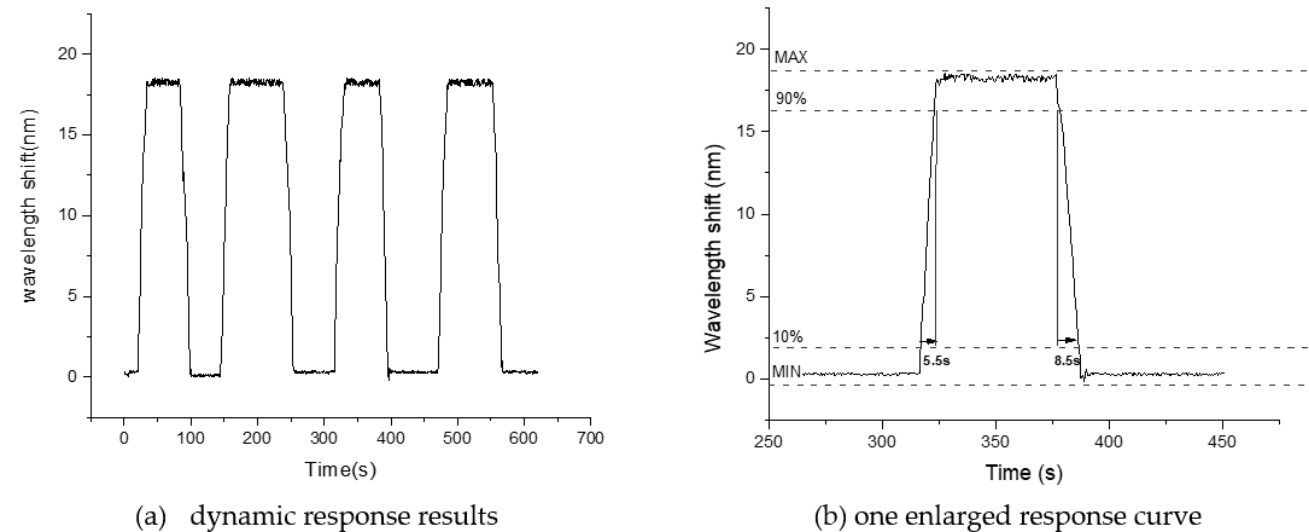
Figure 6. The dynamic responding experimental curves of 54%RH.